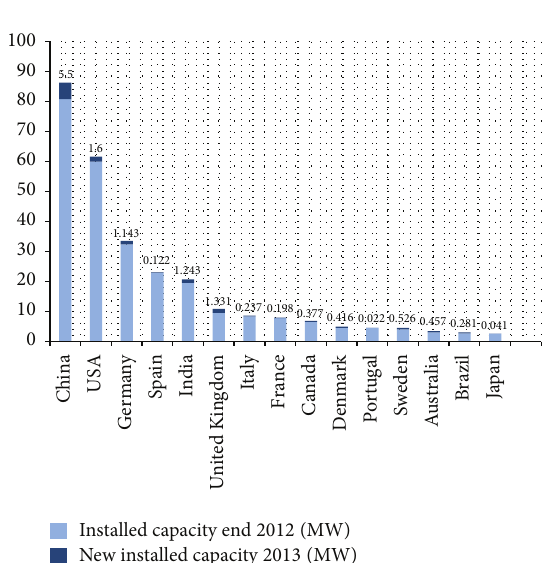
Figure 2: Total installed capacity 2013